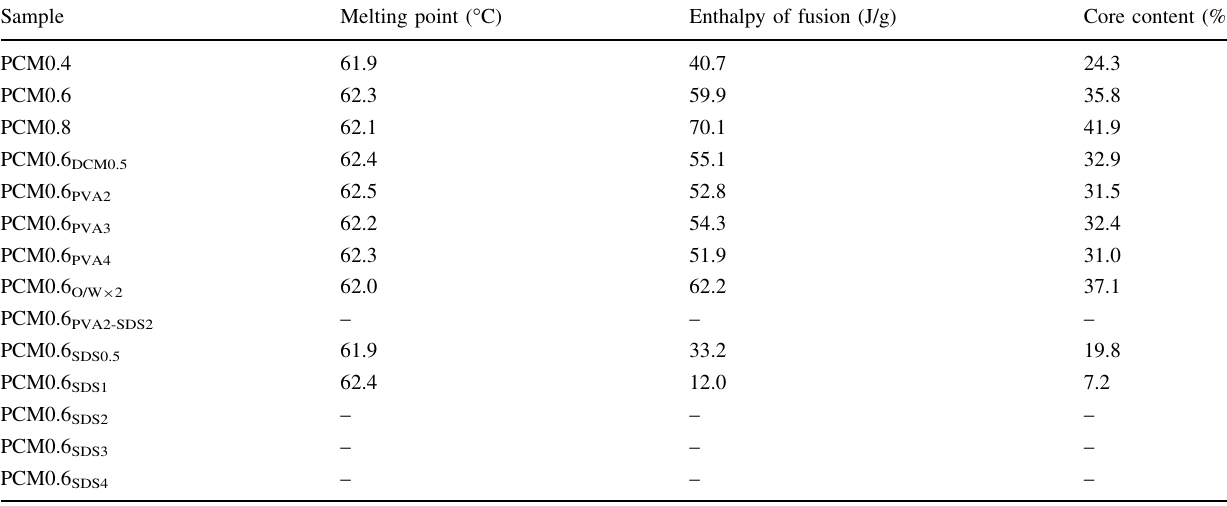
Table 2 Thermal properties of PLA–PA microPCM Sample Melting point ( (cid:3)